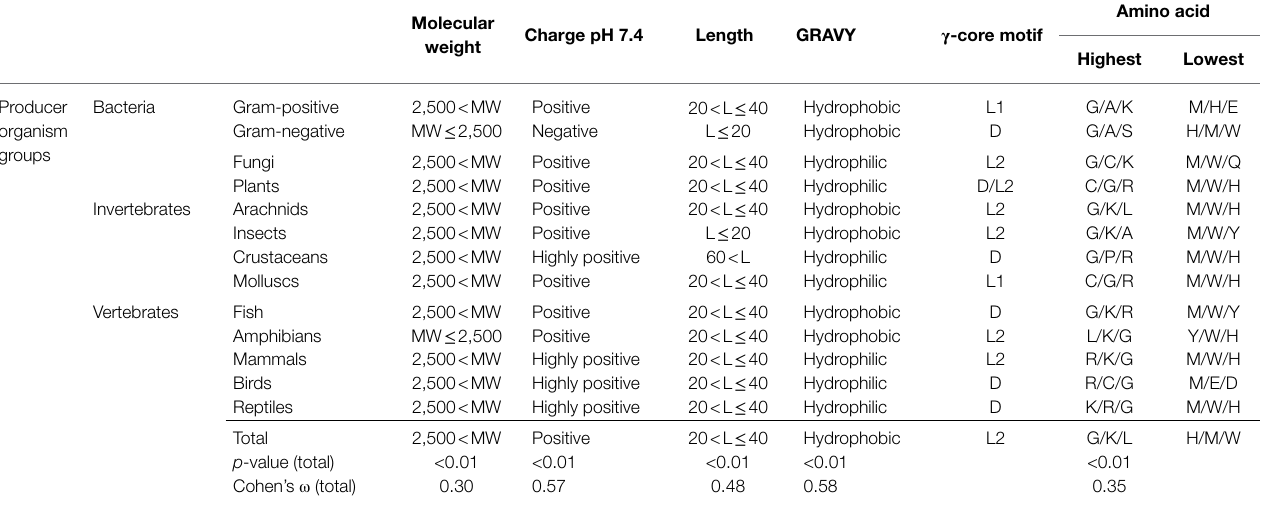
TABLE 1 | Maximum and minimum values of AMP properties in association with the producing organism